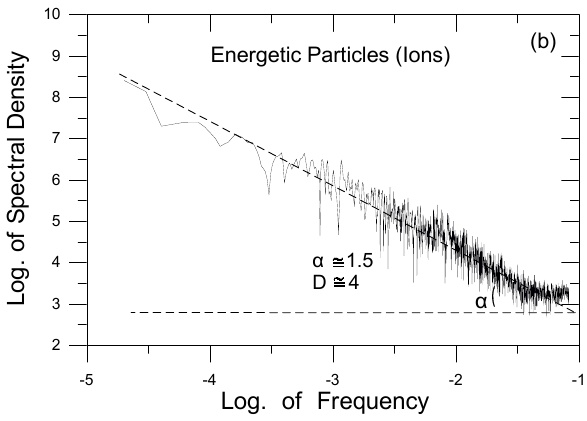
Figure 1 Fig. 1. Power spectrum of the full magnetosphere energetic ions